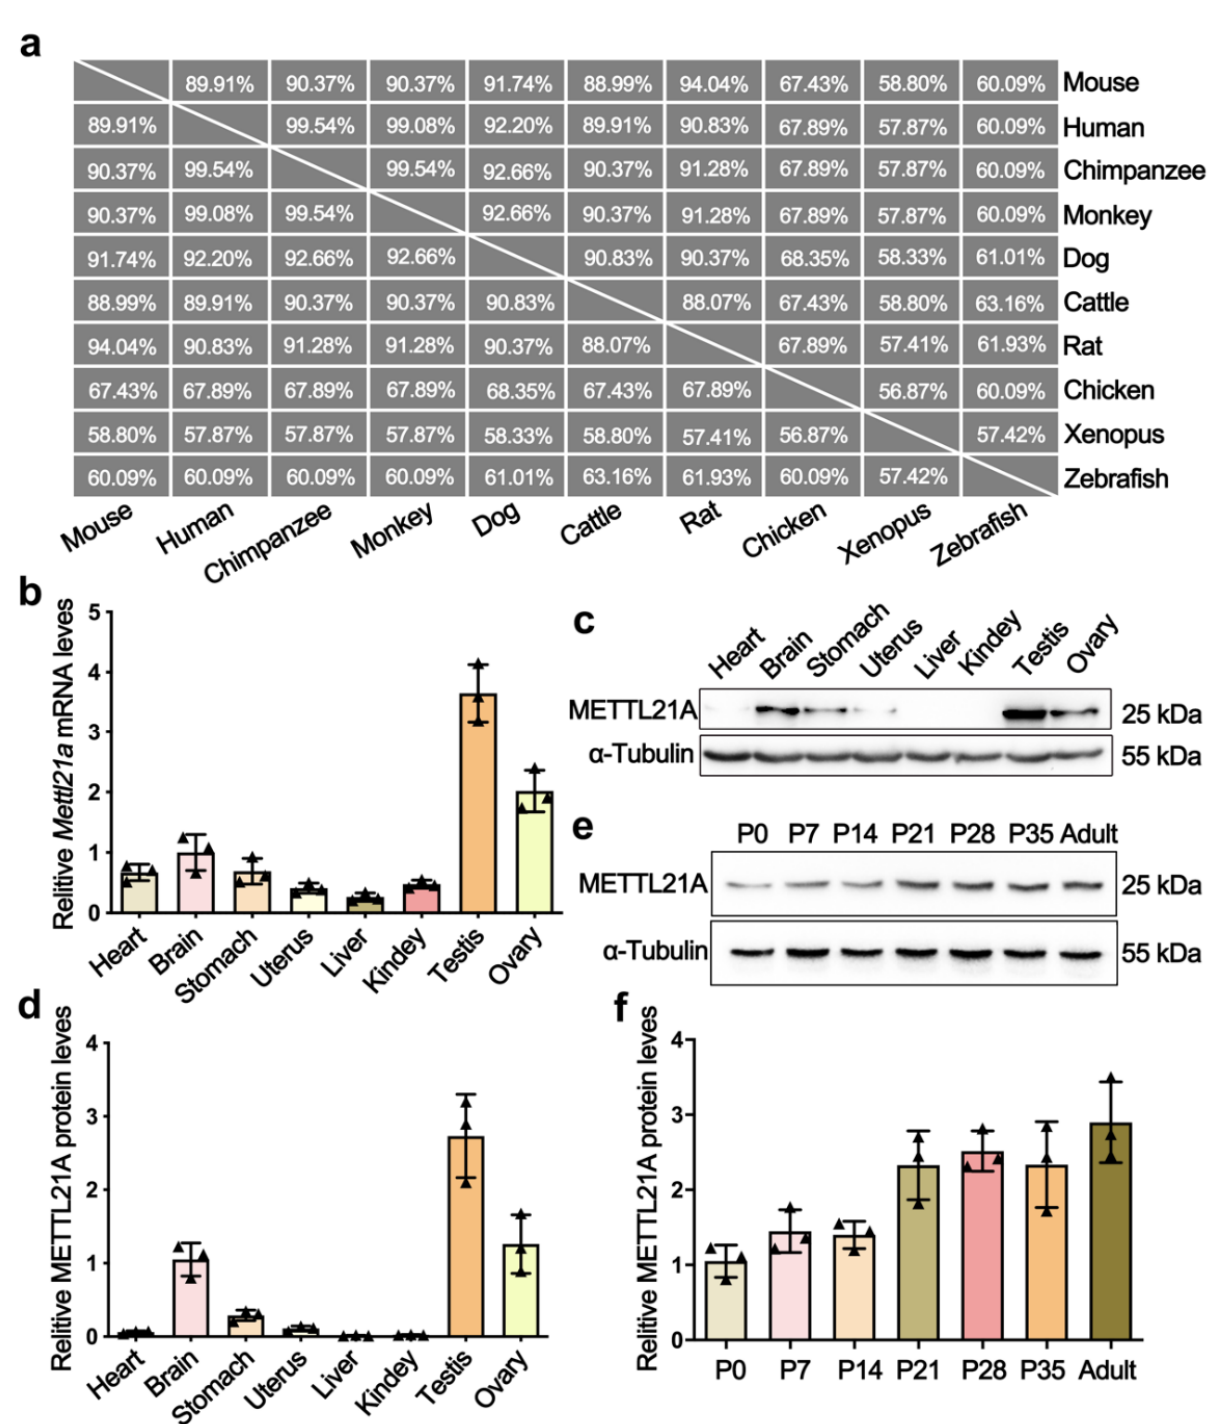
Figure 1. The expression profiles of METTL21A in multiple tissues and developing testes from mice. ( a ) A high degree of conservation of METTL21A in amino acid sequences was acquired from the NCBI database among 10 species. ( b ) RT-qPCR showing Mettl21a mRNA levels in multiple organs using Arbp as internal control. Data are presented as mean ± SEM, n = 3. The three values are indicated as three triangles on each bar. The following bar charts are the same unless otherwise stated. ( c ) Western blot is showing the protein levels of Mettl21a in various organs. ( d ) Quantification of relative Mettl21a protein levels in ( c ). ( e ) Western blot showing the protein levels of Mettl21a in developing testes. ( f ) Quantification of relative Mettl21a protein levels in ( d ). Data are presented as mean ± SEM, n = 3.